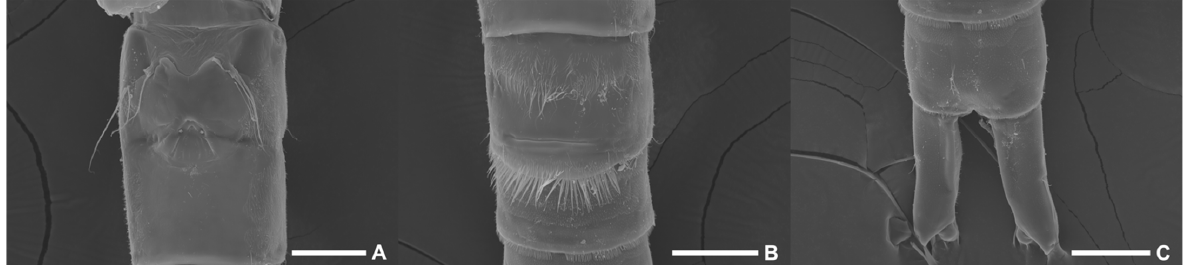
Figure 5. Scanning electron microscopy images of Phyllopodopsyllus saywakimi sp. nov. female (paratype 4) in ventral view: ( A ) genital double-somite; ( B ) third and fourth urosomites; ( C ) fifth urosomite and caudal rami. Scale bars: 50 µm.